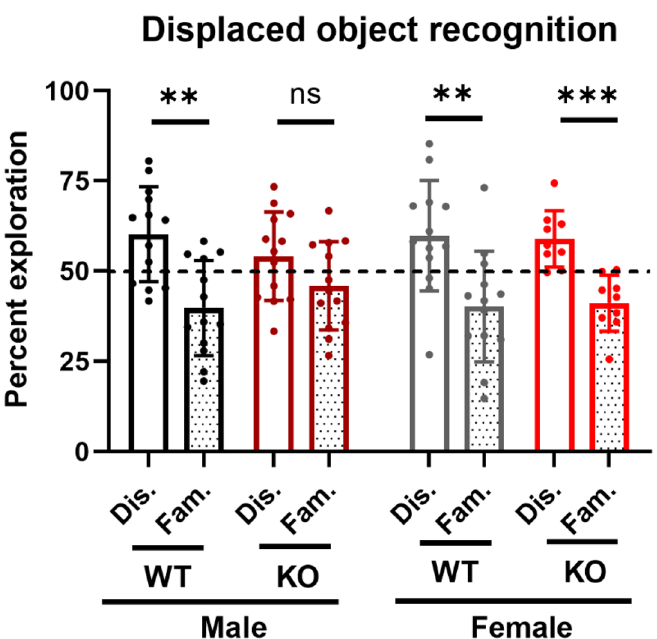
Figure 7. Male NCS1-KO mice show impaired displaced object recognition. ( A ) Both male and female NCS1-WT mice showed normal memory acquisition as determined by the increased preference for the displaced object (two-tailed unpaired t-test, with correction for multiple comparisons, p = 0.002 for male NCS1-WT and p = 0.006 for female NCS1-WT). Male NCS1-KO mice showed impaired displaced object recognition because they spent similar time exploring the displaced object as the familiar object (t-test, p = 0.10). Interestingly, female NCS1-KO mice show intact displaced object recognition ( p < 0.001). The dotted line denotes 50%, or no preference. Error bars show ± SD. Male NCS1-WT: n = 13, male NCS1-KO: n = 13, female NCS1-WT: n = 12, female NCS1-KO: n =